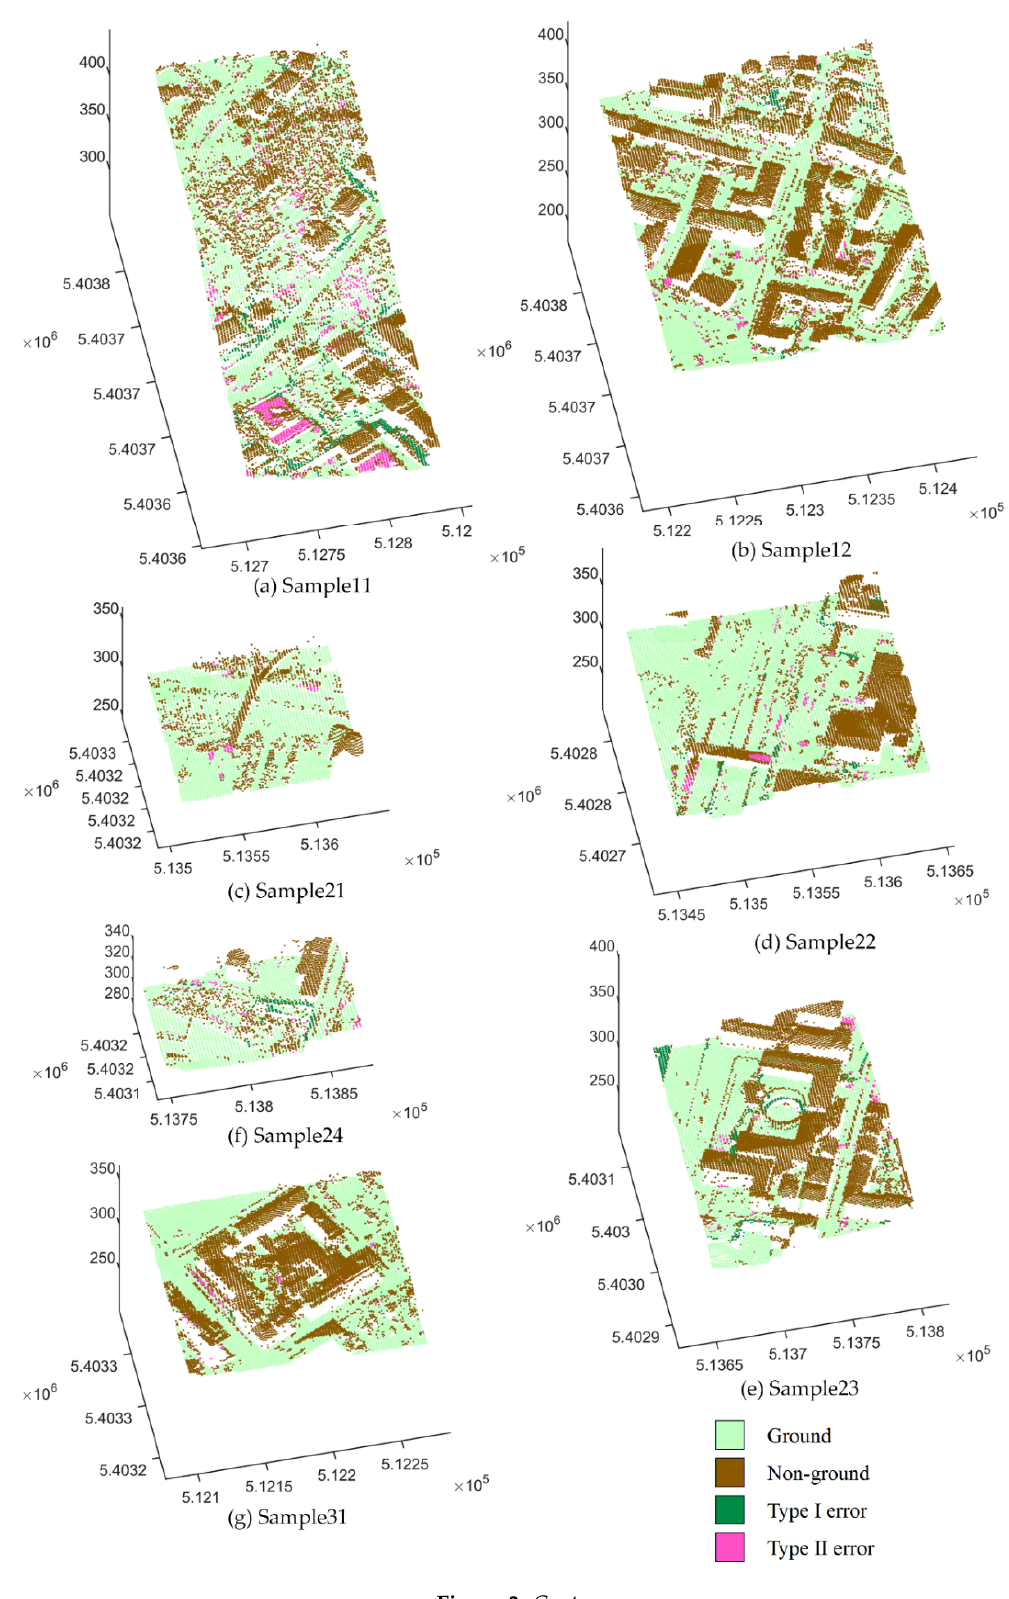
Figure 3. Figure 3. Error distribution of International Society for Photogrammetry and Remote Sensing (ISPRS) samples (continued).